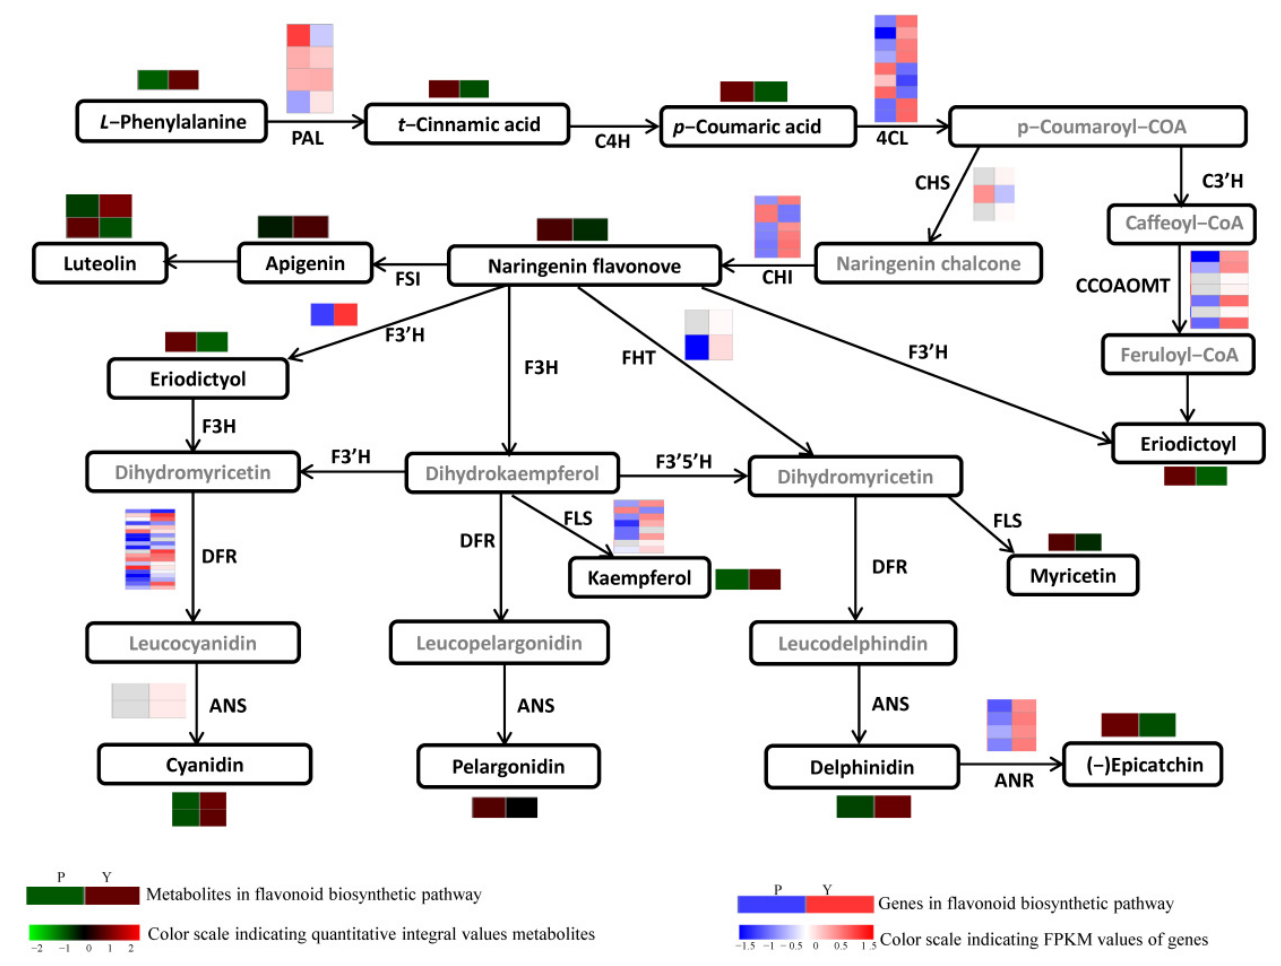
Figure 9. Part of the flavonoid biosynthesis pathway that reveals the different expression levels of related genes and different contents of metabolites.